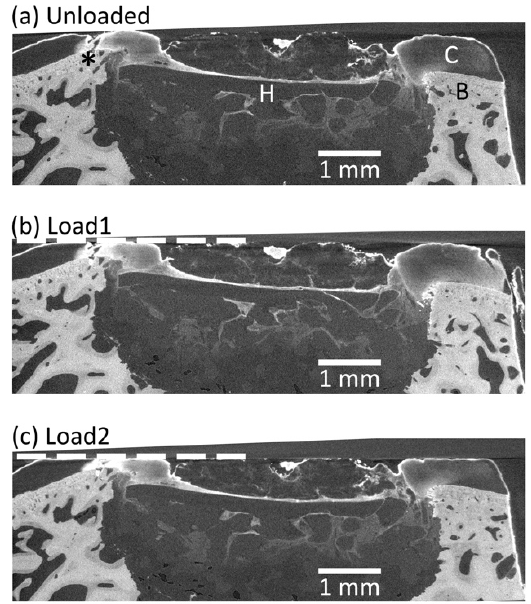
Figure 3. A transverse slice of the micro-CT scan of an ex vivo osteochondral sample taken from the implant site after 6 weeks, in situ tested with successive levels of load applied: ( a ) unloaded reference scan; ( b ) first level of compression; ( c ) second level of compression. The system components are labelled in panel a: C = Cartilage, B = Bone, H = Hybrid scaffold implant. A peak in the height of the bone, seen on the left-hand side of the defect (*), impeded loading of the cartilage and hybrid. The dashed line represents displacement of the compression platen.